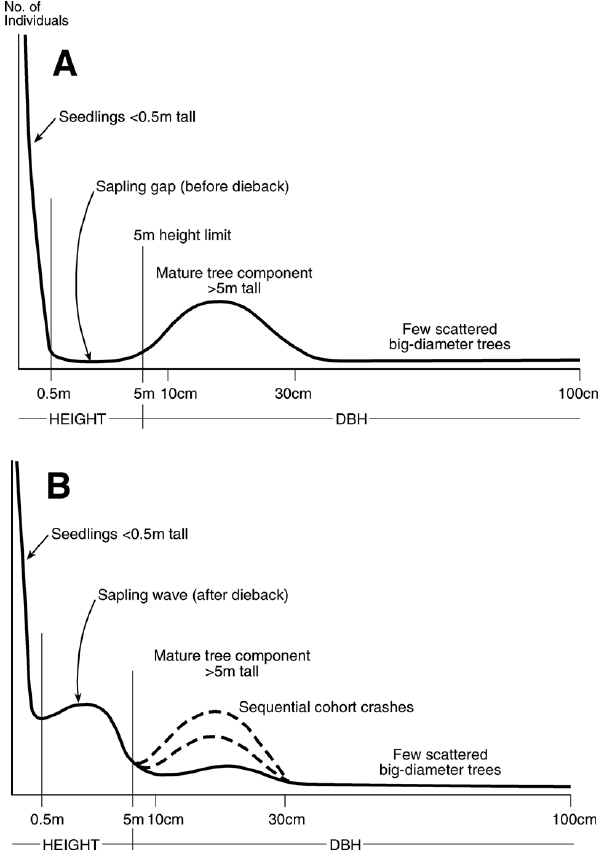
Fig. 9. The study area with plot locations. Black circles represent permanent plots (26/62). Three dieback types are shown. Dryland dieback refers to plots outside the mapped area, from the Saddle Road south into Hawaii Volcanoes National Park. Gap-formation dieback refers to plots on Mauna Kea in the wetland and bog-formation territory (map after Jacobi et al., 1983)